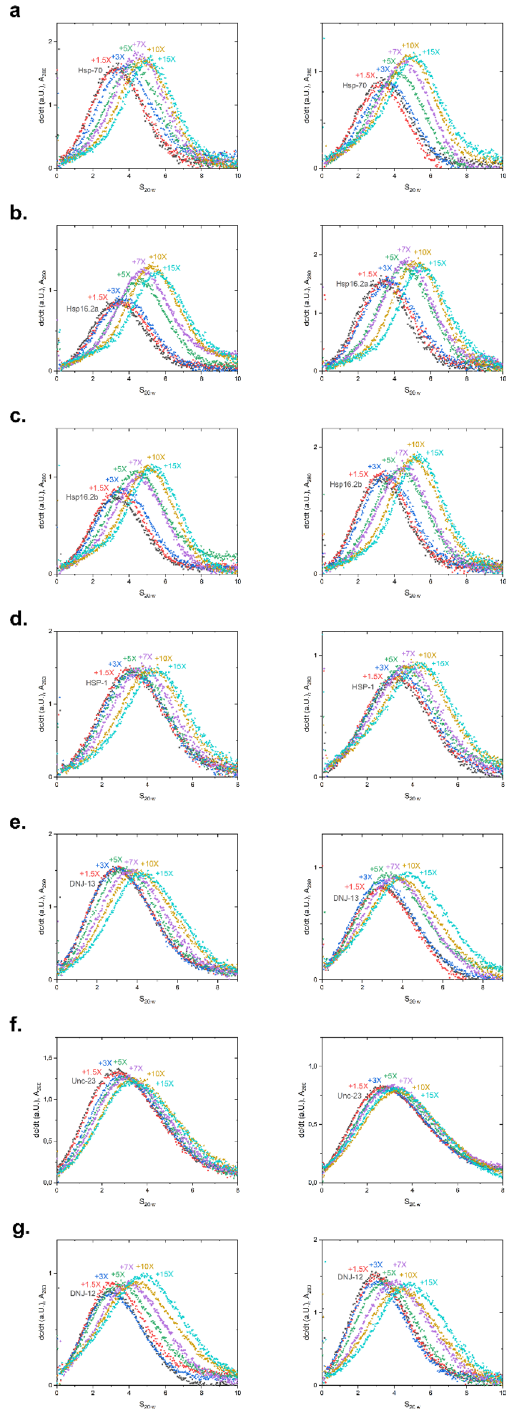
Figure 5. Analysis of interaction between selected promotors and Hsf-1 DBD via titration in SV-AUC. HSF-1 DBD was titrated to each promoter in concentrations ranging from a 0–15-fold excess. A shift to the right represents DNA-binding by the HSF-1 DBD. dc/dt plots of the absorbance measured at 260 nm (left panel) and at 280 nm (right panel). Respective promoters used: ( a ) HSP-70; ( b ) HSP16.2a; ( c ) HSP16.2 b; ( d ) HSP-1; ( e ) DNJ-13; ( f ) UNC-23; ( g )